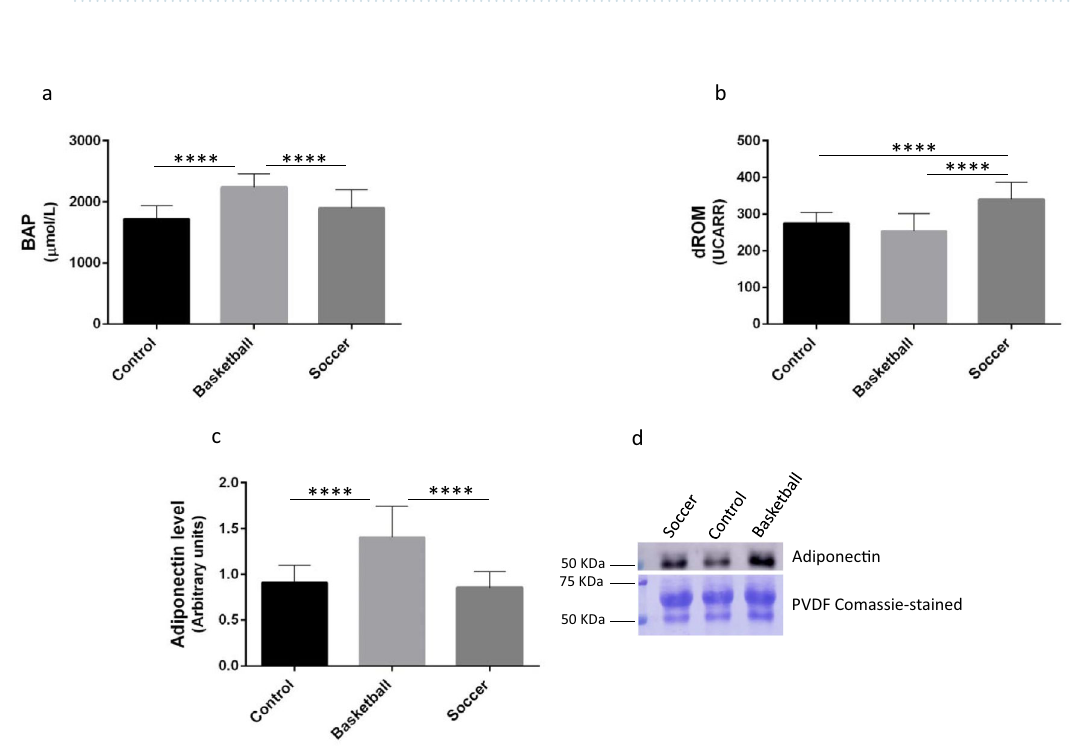
Figure 1. Plasma oxidative stress and Adiponectin determination. ( a ) Antioxidant capacity was measured by BAP Test, ( b ) levels of reactive oxygen metabolites were measured through d-ROM test by a free radical analyzer system, ( c ) Adiponectin level was assessed in 10 µg of proteins from plasma by western blot with adiponectin antibody normalized on total plasma protein content (as reported in methods), ( d ) original western blot from the protein sample All measurements were performed in triplicate and are re-ported in the histograms as mean ± SD. The statistical analysis was carried out by ANOVA Tukey’s test was performed by Graphpad Prism 6 (* p-value < 0.05), (****p-value <